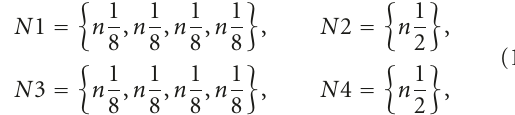
Figure 8: The course of music in parallel voices.